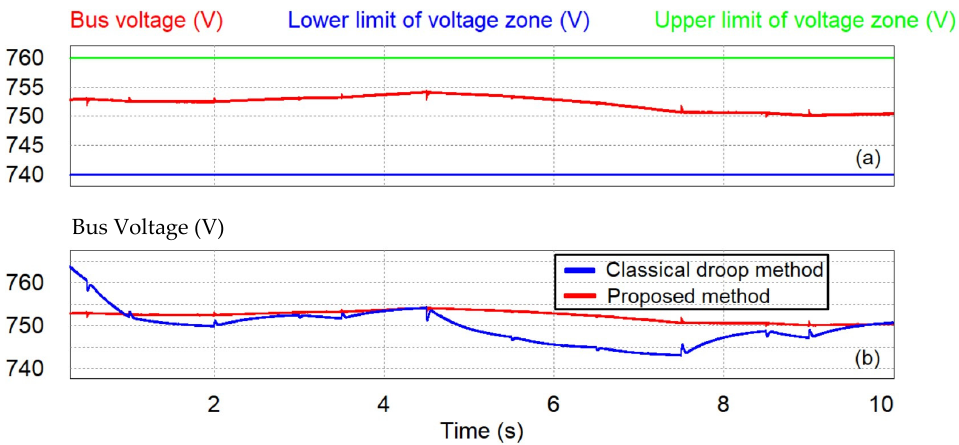
Figure 22. ( a ) The DC bus voltage and the corresponding limits in the proposed method; ( b ) the DC bus voltage in both methods. SCES Voltage (V)